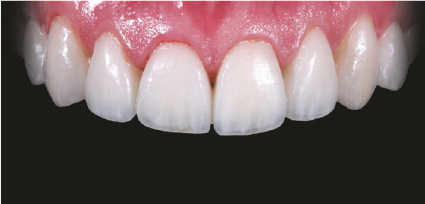
Figure 20: Immediate control image after the cementation of the veneers.